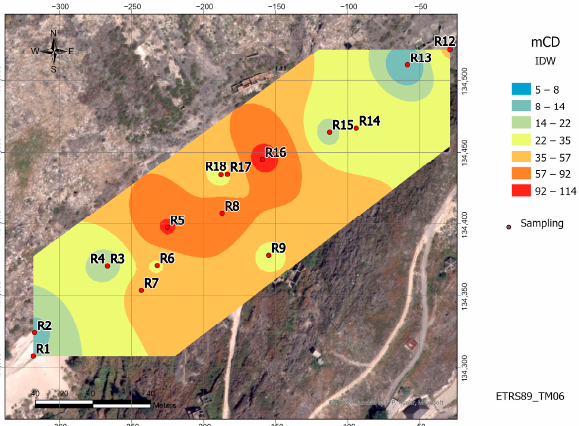
Figure 8. Spatial distribution of mCD index in the Regoufe mine area, inferred by inverse distance weighting in ArcGIS PRO software (ESRI).